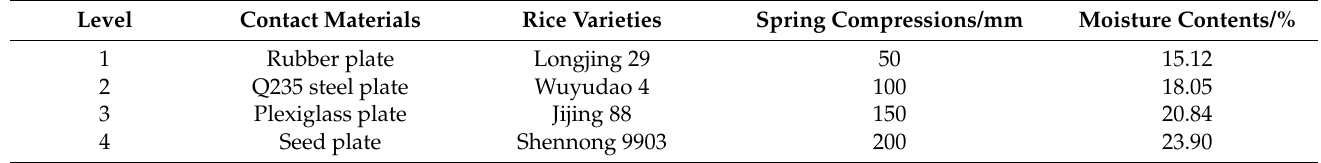
Table 3. Factor level coding table of orthogonal test for restitution